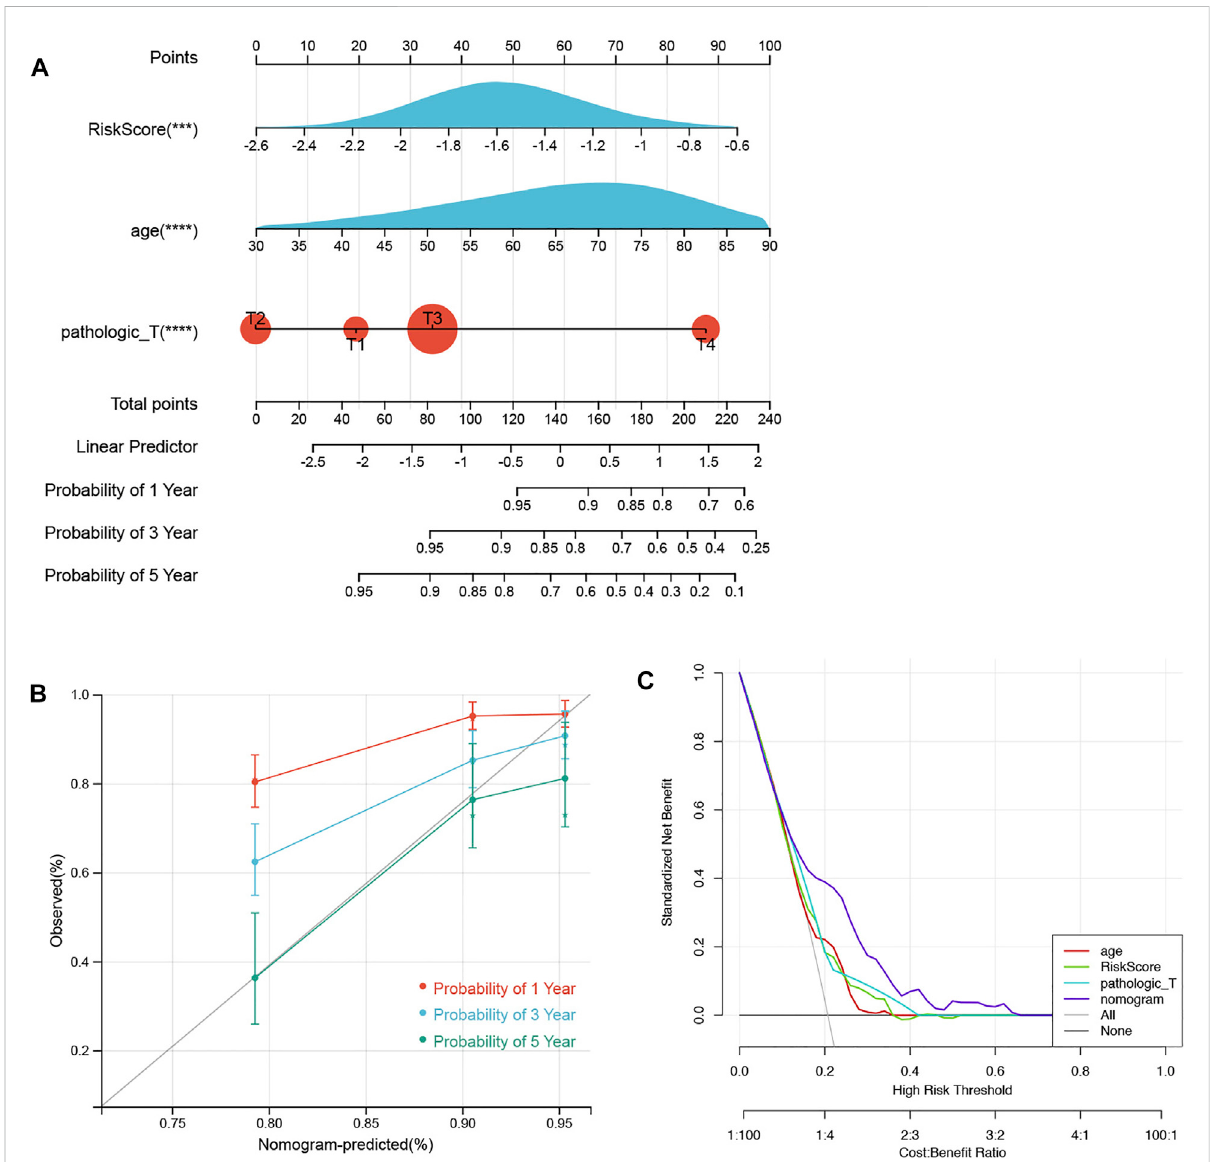
FIGURE 6 Nomograms and calibration curves. (A) Prognostic nomogram was established to predict the OS with 3 independent prognostic factors. (B) Calibration curve was used to validate the nomogram based on the prognostic signature. (C) DCA was used to validate the nomogram based on the prognostic